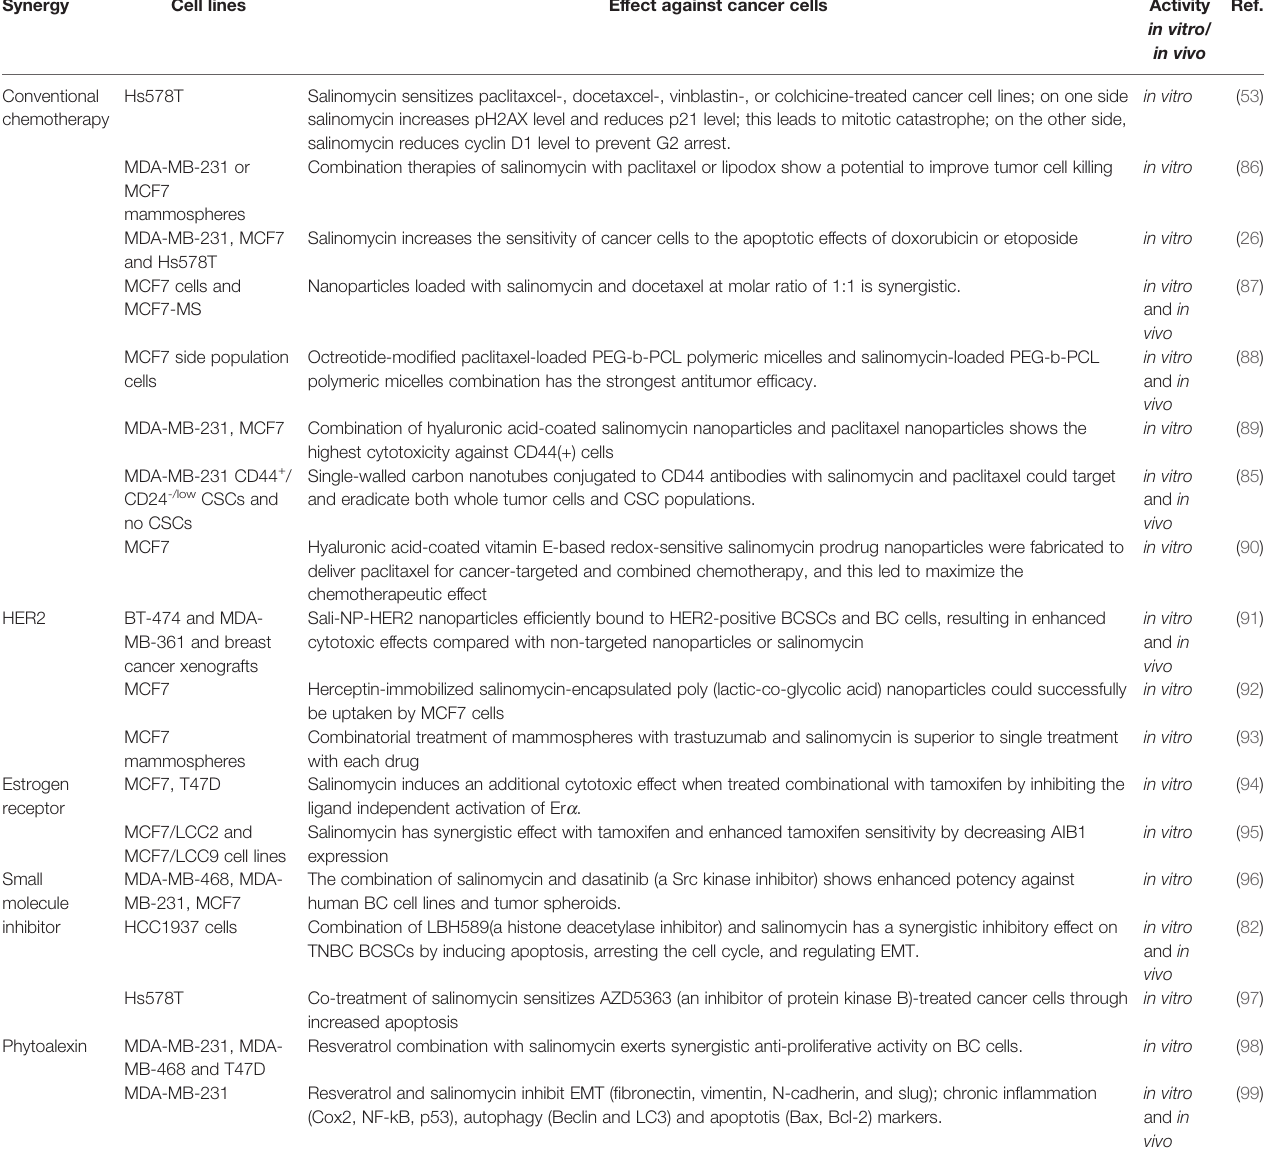
TABLE 3 | Synergistic anticancer co-action of salinomycin with other agents in BC. Synergy Cell lines Effect against cancer cells Activity